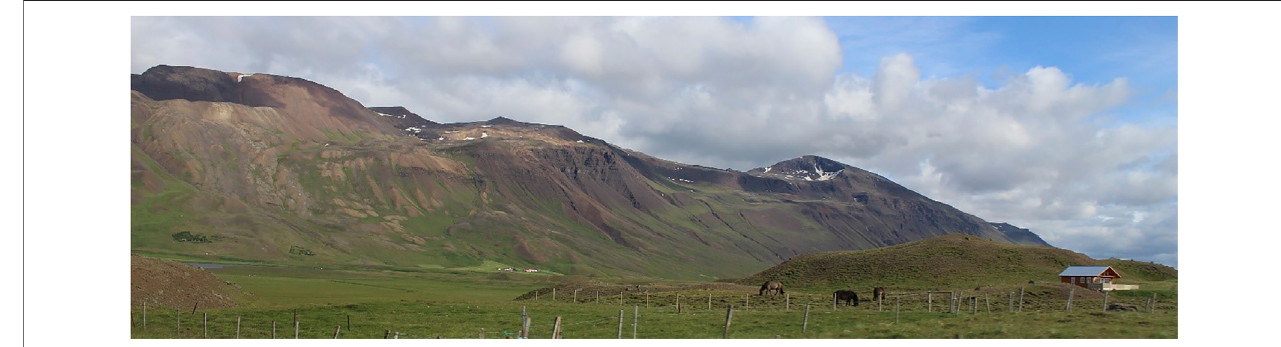
FIGURE 6 | Perspective view of one of the rock avalanches shaping the landscape of the Tröllaskagi peninsula. In the background, the slope is affected by several slope failures, while in the foreground the depositional area extending to the plane is characterised by a hummocky morphology (photo by C. Morino).